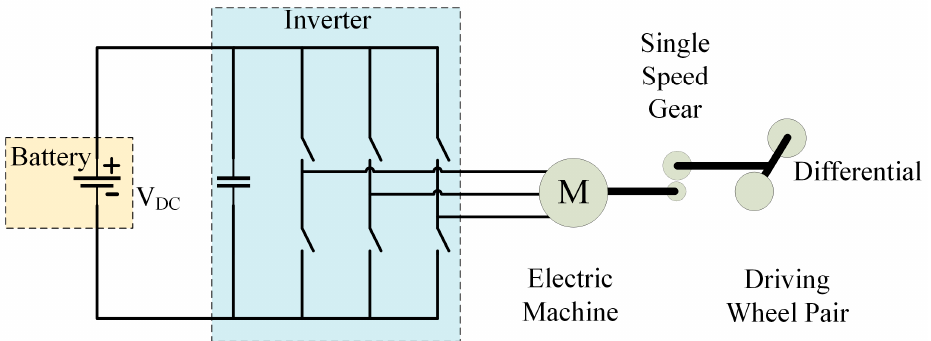
Figure 3. BEV configuration. The battery’s DC power is converted to AC by the inverter to run the motor. Adapted from [5].